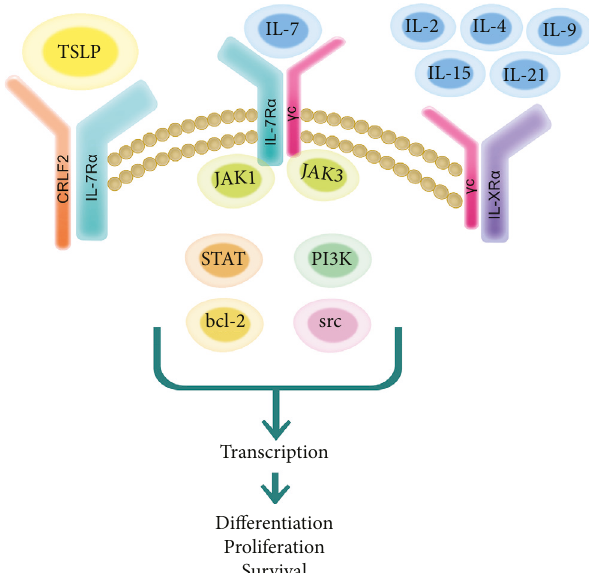
Figure 1: Schematic of IL-7R signal transduction. IL-7 and its cell- surface receptor — a heterodimer consisting of the IL-7R α and the common γ chain ( γ c) — form a ternary complex that engages the JAK-STAT pathway. The subsequent downstream activation of PI3K, bcl-2, and src kinases leads to gene transcription. IL-7R signal transduction is important in directing the di ff erentiation, proliferation, and survival of immune cells including B, T, and natural killer (NK) cells. The IL-7R α chain is shared with another receptor recognizing thymic stromal lymphopoietin (TSLP). In this scenario, the IL-7R α noncovalently associates with the cytokine receptor-like factor 2 (CRLF2). Likewise, the γ c is shared with other receptors speci fi cally recognizing IL-2, IL-4, IL-9, IL-15, and